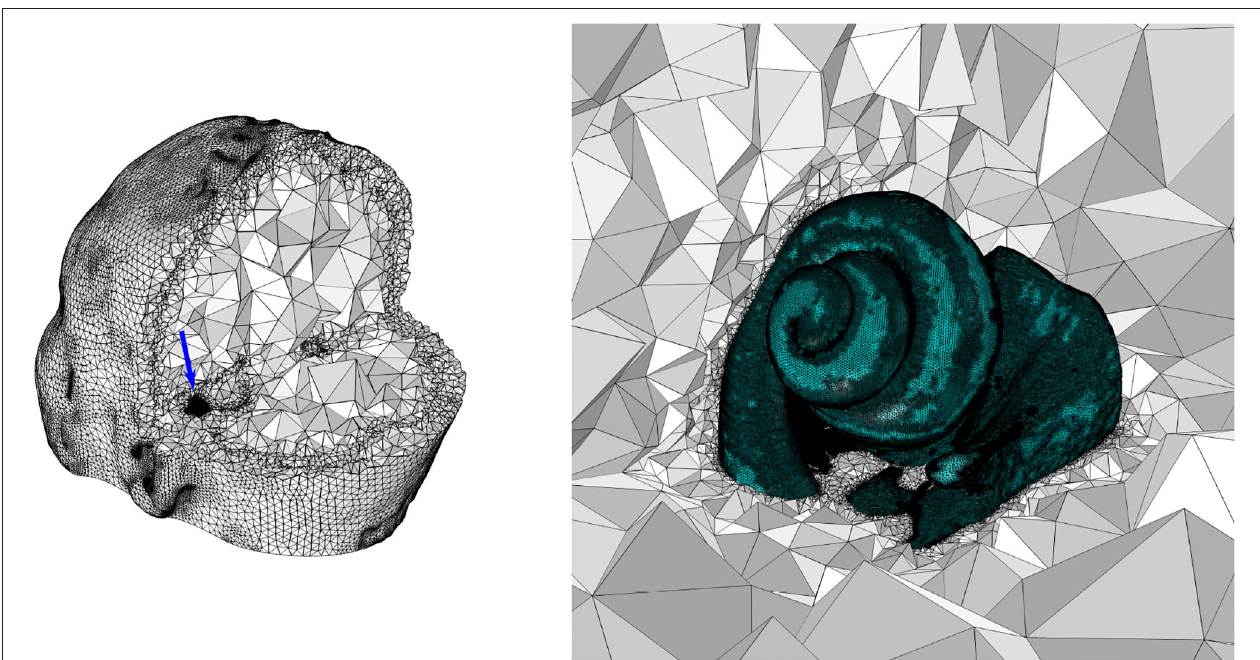
FIGURE 1 | Left: A dissected view of the FE mesh of the whole head model. The blue arrow indicates the location of the cochlea. Right: A zoomed-in view of the cochlea (and the nerve), indicated by the blue arrow in the left